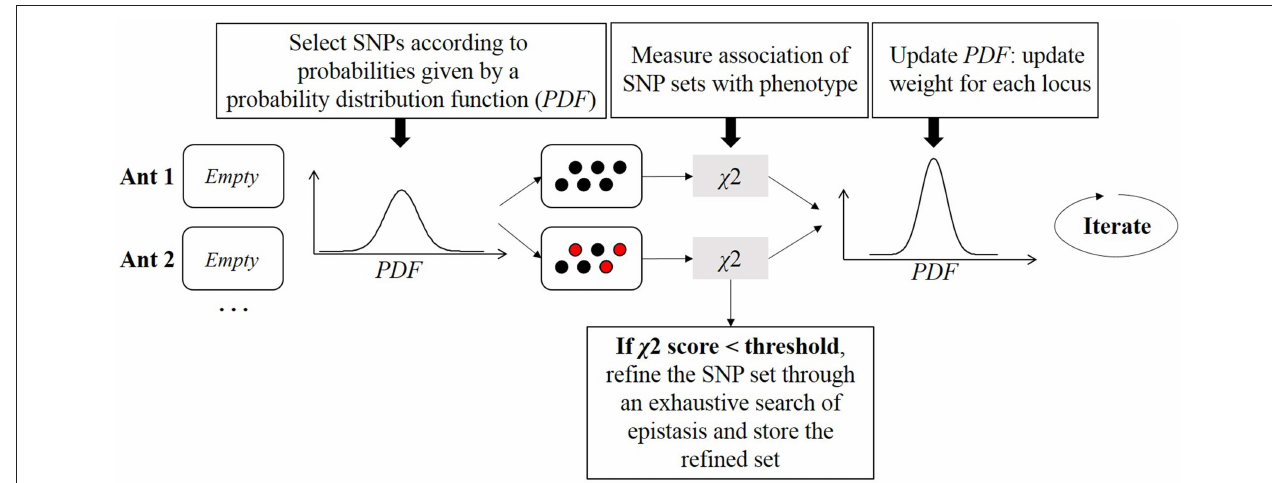
FIGURE 8 | Ant colony optimization procedure. For each ant, multiple SNPs are drawn. The probability distribution function (PDF) gives the probability of each SNP to be drawn. Once an ant is filled with a SNP set, joint association of this SNP set with the phenotype is evaluated with a χ 2 test. For each ant, the PDF is updated according to p -values resulting from χ 2 tests, such that SNPs efficiently classifying individuals will have a higher probability of being drawn in the next